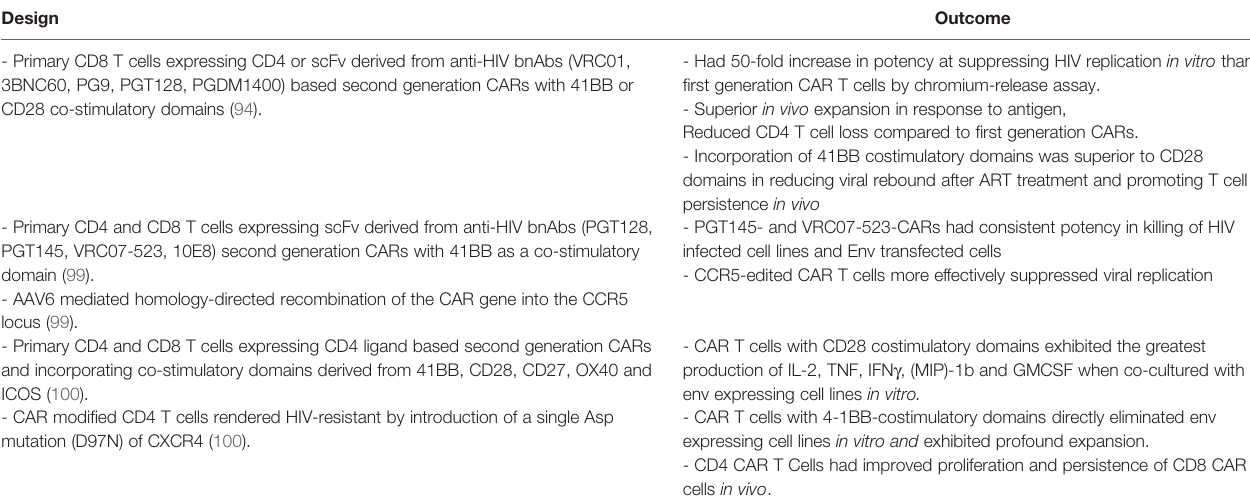
TABLE 3 | Recent preclinical testing of second-generation anti -HIV CAR T cells. Design